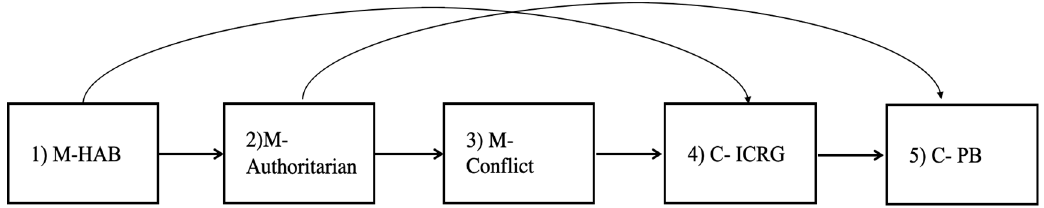
Figure 3. Study’s operational model and expected effects.